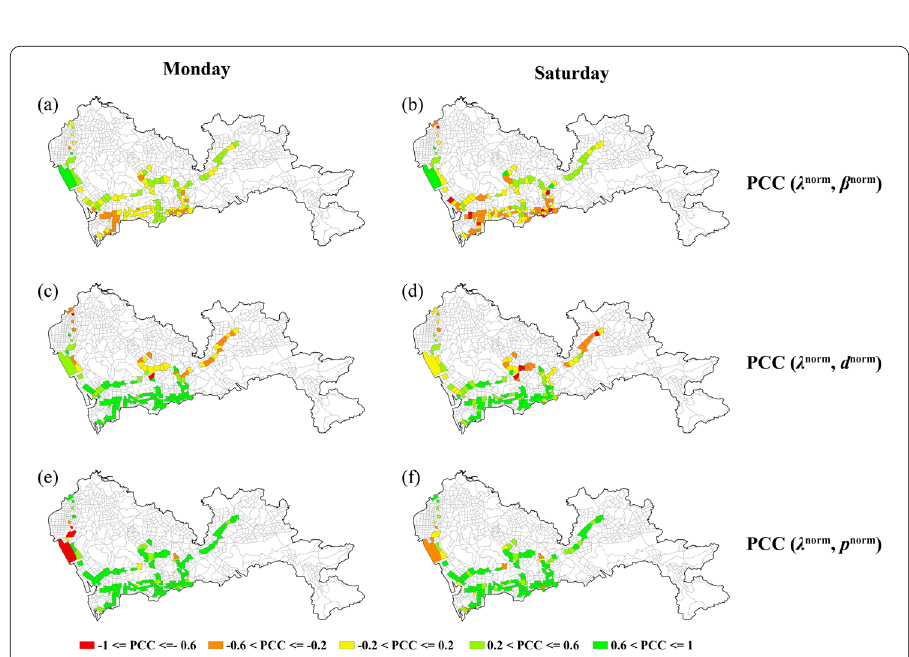
Figure 8 Spatial distribution of destination zones of SDNs with different levels of correlations between ( a ), ( b ) λ norm and β norm , ( c ), ( d ) λ norm and d norm , ( e ), ( f ) λ norm and p norm